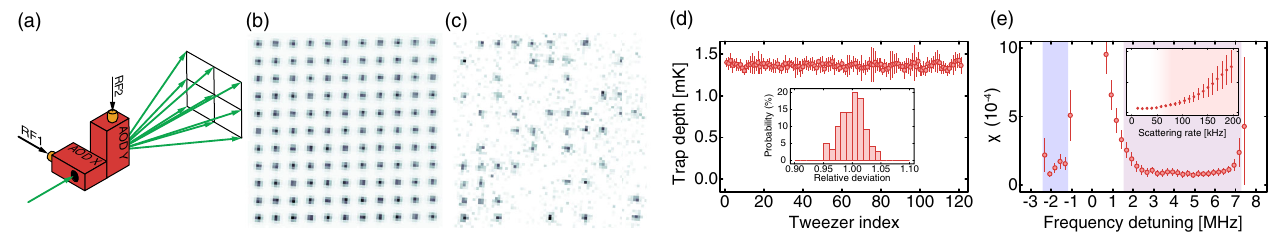
FIG. 3. Tweezer arrays. (a) We create two-dimensional arrays of tweezers with two perpendicular acousto-optic deflectors (AODs). A 4 f telescope (not shown) maps the light between the two AODs. Each AOD is driven by a polychromatic rf waveform with tones uniformly spaced in frequency. (b) Average fluorescence image (of 6000 experimental runs) of single strontium atoms in a square array of 11 × 11 tweezers. The interatomic distance is ∼ 9 μ m. (c) Single-shot image of single strontium atoms in a square array of 11 × 11 tweezers. The filling fraction is close to 0.5. (d) Trap depth for all 121 tweezers, as measured by spectroscopy on the 1 S 0 ↔ 3 P 1 j ϕ transition. Inset: Histogram of trap depths across the array. The standard deviation of relative trap depths is 2%, demonstrating homogeneity. (e) The loss coefficient χ as a function of cooling frequency, averaged over an 11 × 11 linearly polarized array. Features are similar to those seen in a single magic tweezer, but pushed farther away from the free-space resonance due to larger differential polarizability in linear light. Inset: χ versus blue scattering rate under Sisyphus cooling, averaged over the